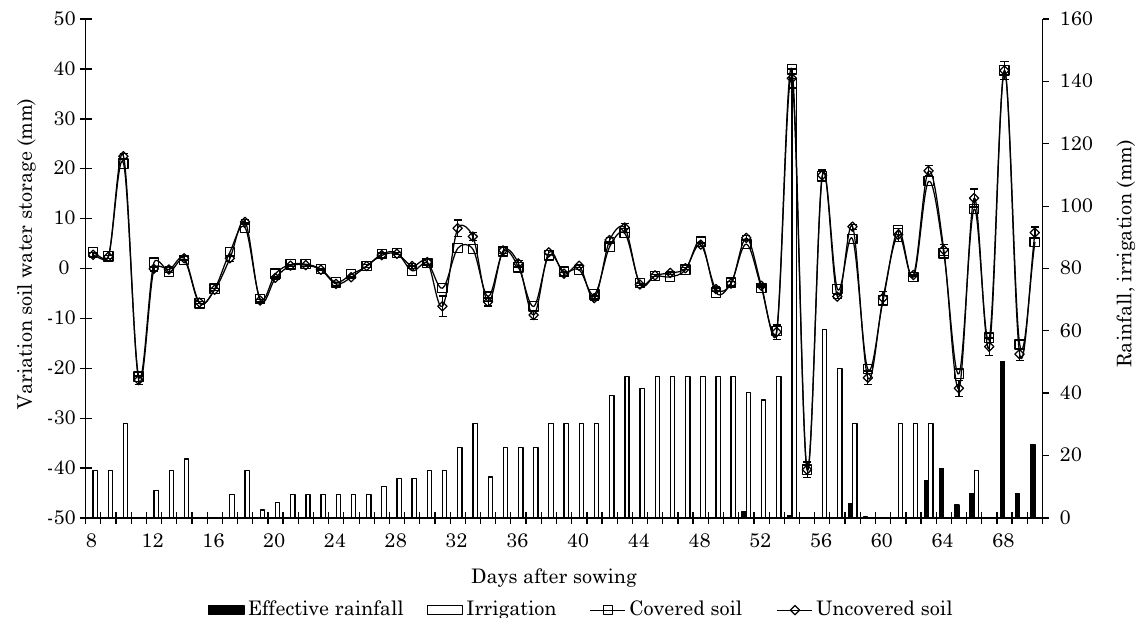
Figure 4. average daily variation in soil water storage, with the corresponding standard deviations throughout the muskmelon